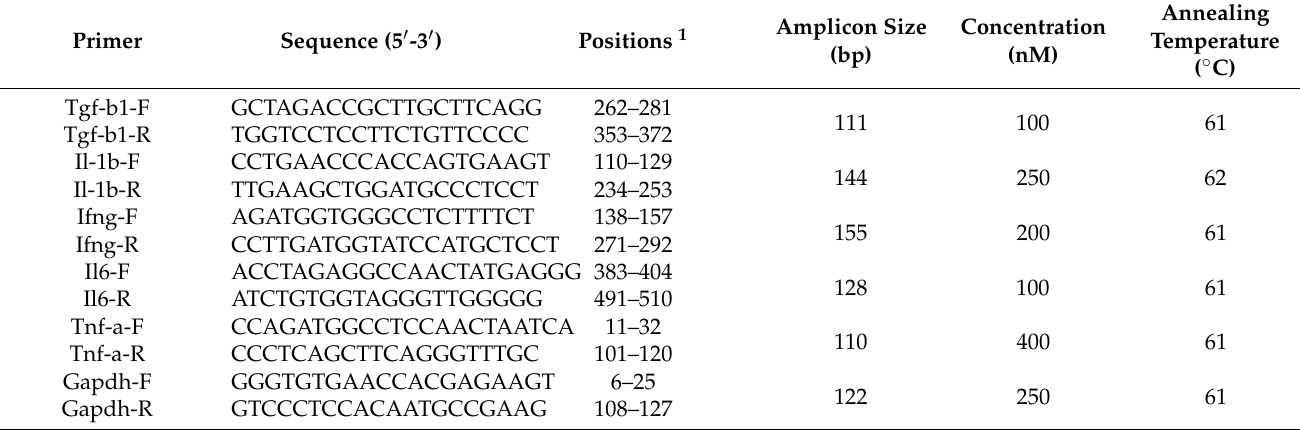
Table 1. Primers used for gene expression